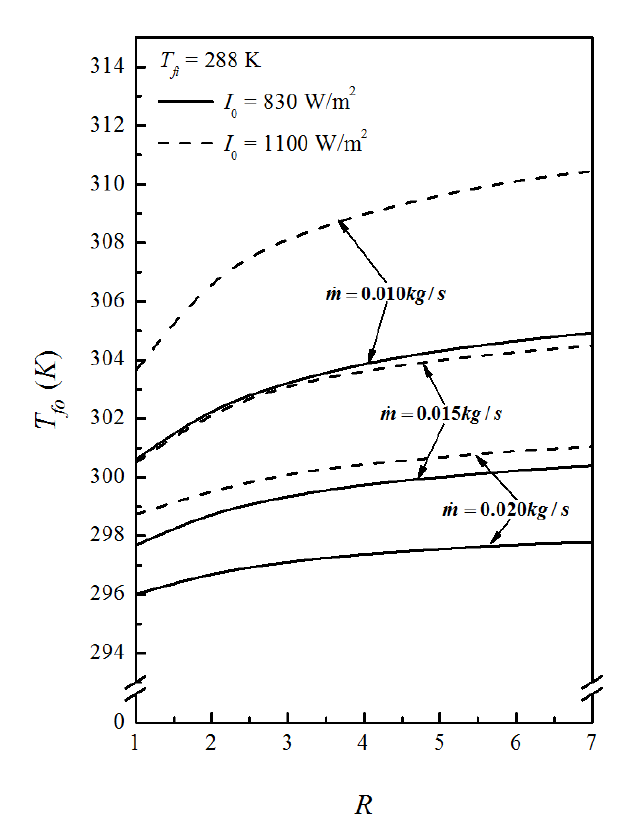
Figure 2. Air outlet temperature ( 288K =